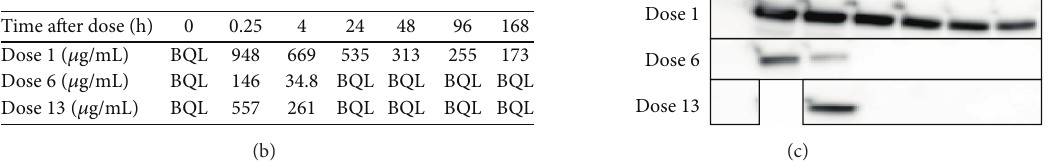
Figure 4: (a) SEC profile of toxicology study animal. 678 nM Fab488 was incubated with 20% serum samples from a cynotoxicology study with huDVD as described in Section 2 and separated by size exclusion chromatography with fluorescence detection. Peak 1 is the free dye (DyLight 488), peak 2 is Fab488, peak 3 is the complex of Fab488 and huDVD, peak 4 is unspecific binding, peak 5 is the complex of Fab488 and huDVD and one ADA, peak 6 is the complex of Fab488, huDVD, and two ADAs, and peaks under number 7 represent bigger complexes containing Fab488, huDVD, and ADA. Graph 1 shows the chromatographic traces of the predose sample (dose 1 pre) of one animal before the first dose and 15 minutes, 4 hours, 24 hours, 48 hours, 96 hours, and 168 hours after the first dose (from dark purple to dark green, dose 1 15min–dose 1 168 h). Graph 2 shows chromatogram traces of the predose sample (dose 6 pre) of the same animal before dose 6 and 15 minutes, 4 hours, 24 hours, 48 hours, 96 hours, and 168 hours after the 6th dose (from dark purple to dark green, dose 6 15 min–dose 6 168 h). Graph 3 shows the chromatographic traces of the predose sample (dose 13 pre) of the same animal before dose 13 and 4 hours, 24 hours, 48 hours, and 96 hours after the 13th dose (from dark purple to green, dose 13 15min–dose 13 96 h). The 15 minutes and 168 hours postdose samples were missing here. (b) PK profile of the same study animal measured with ligand binding assay. The concentration in 𝜇 g/mL of huDVD was measured with an antigen-based ligand binding assay using Mesoscale Discovery ECL technology. The figure depicts the concentration in 100% serum in the predose and postdose samples of doses 1, 6, and 13 for the same animal as in (a). BQL indicates that the values were below the lower limit of quantitation. (c) Relative quantitation of total amounts of huDVD with western blot. The same study samples as in (a) and (b) were separated by nonreducing SDS-PAGE and analyzed with western blot as described in Section 2. The huDVD signal is